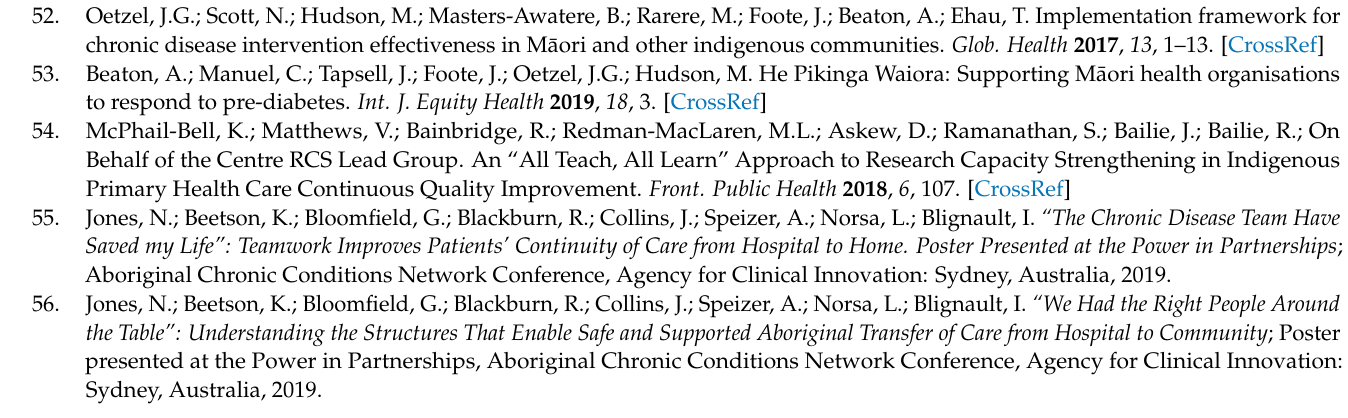
the Table”: Understanding the Structures That Enable Safe and Supported Aboriginal Transfer of Care from Hospital to Community ; Poster presented at the Power in Partnerships, Aboriginal Chronic Conditions Network Conference, Agency for Clinical Innovation: Sydney, Australia,